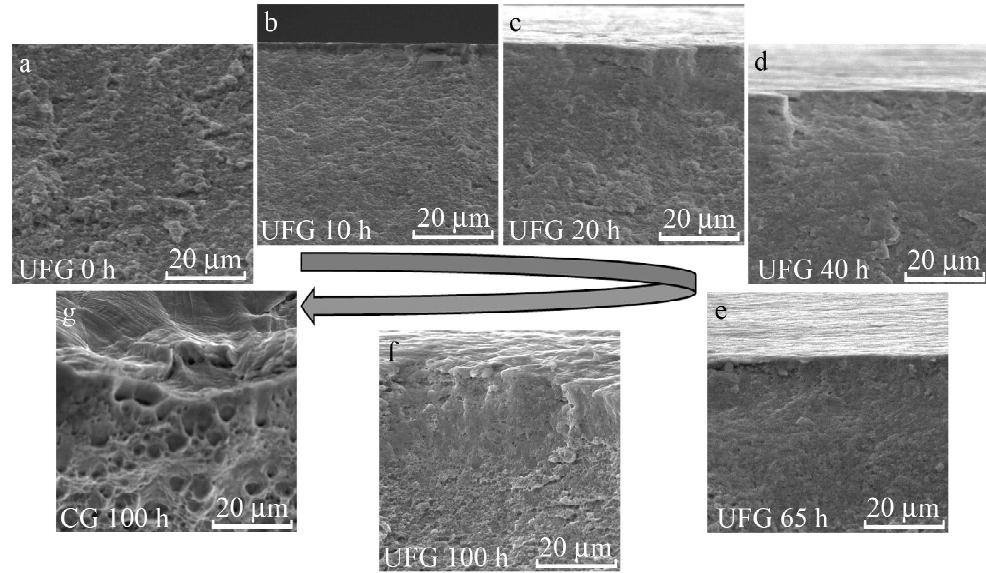
Fig. 10. The characteristic SEM micrographs of the fracture surfaces in UFG-CrNiMo steel depending on hydrogen-charging regime (a–f) and in CG-CrNiMo steel after 100 h-hydrogen-charging (g). One side of the fracture surface is presented for each specimen on images